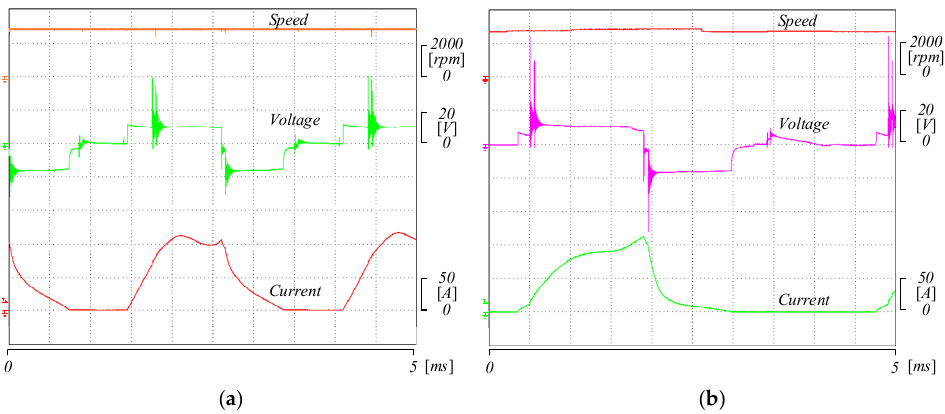
Figure 18. Test results under rated operating conditions. ( a ) Traditional 12/8 SRM; ( b ) Proposed 6/5 SRM.